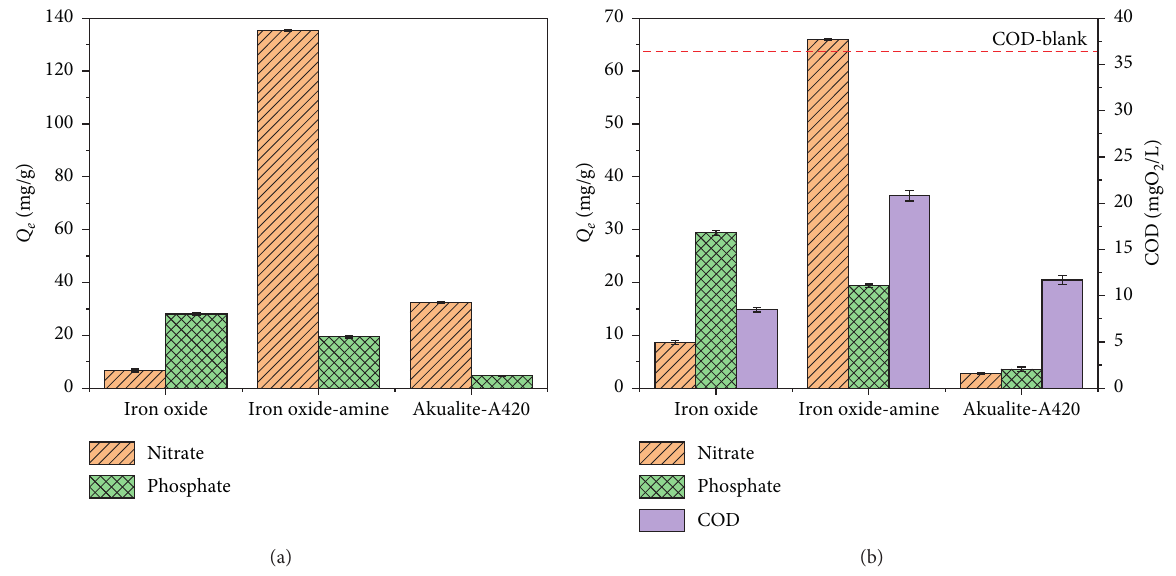
Figure 12: (a) Nitrate and phosphate adsorption capacity in synthetic wastewater; (b) nitrate and phosphate adsorption capacity in real wastewater, and COD of real wastewater before and after adsorption of ferric oxide, ferric oxide-amine, and Akualite A420